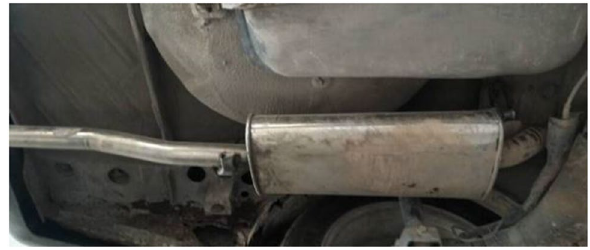
Fig. 3 Local exhaust system hook position